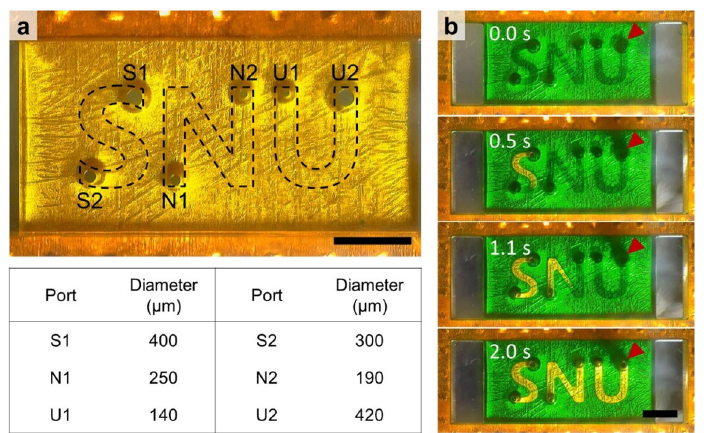
Figure 3. Rendering of multiple discrete microchannels using different port sizes. ( a ) Image of the underside of a device with three HRs in the shapes of ‘S’, ‘N’, and ‘U’, surrounded by a rectangular LR. Loading and aspiration occur through port U2. Opposing port sizes decrease from S1 to U1 as indicated in the bottom table. Scale bar, 2 mm. ( b ) Sequential snapshots (top to bottom) viewed from the bottom of the device during